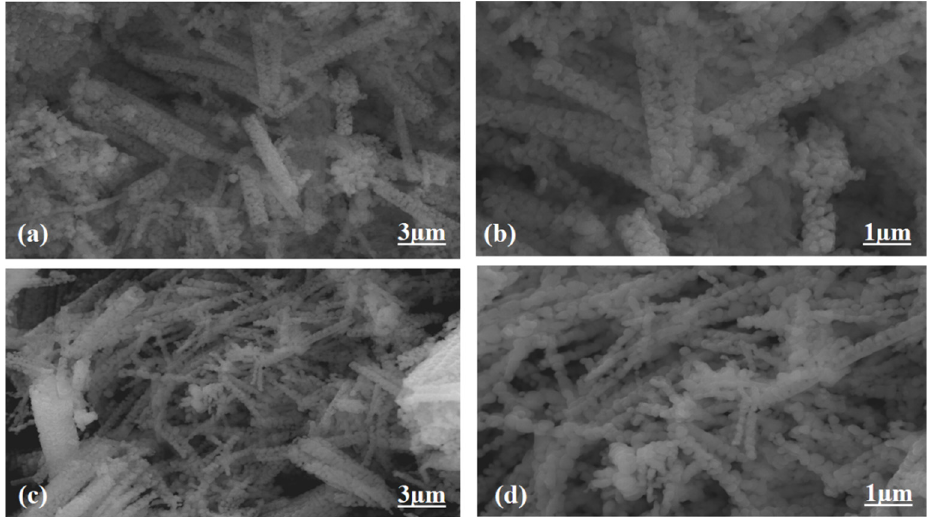
Figure 3. Distinctive SEM images of ( a,b ) pure Co 3 O 4 and ( c,d ) Co 3 O 4 nanocrystals prepared with polyethyleneimine.